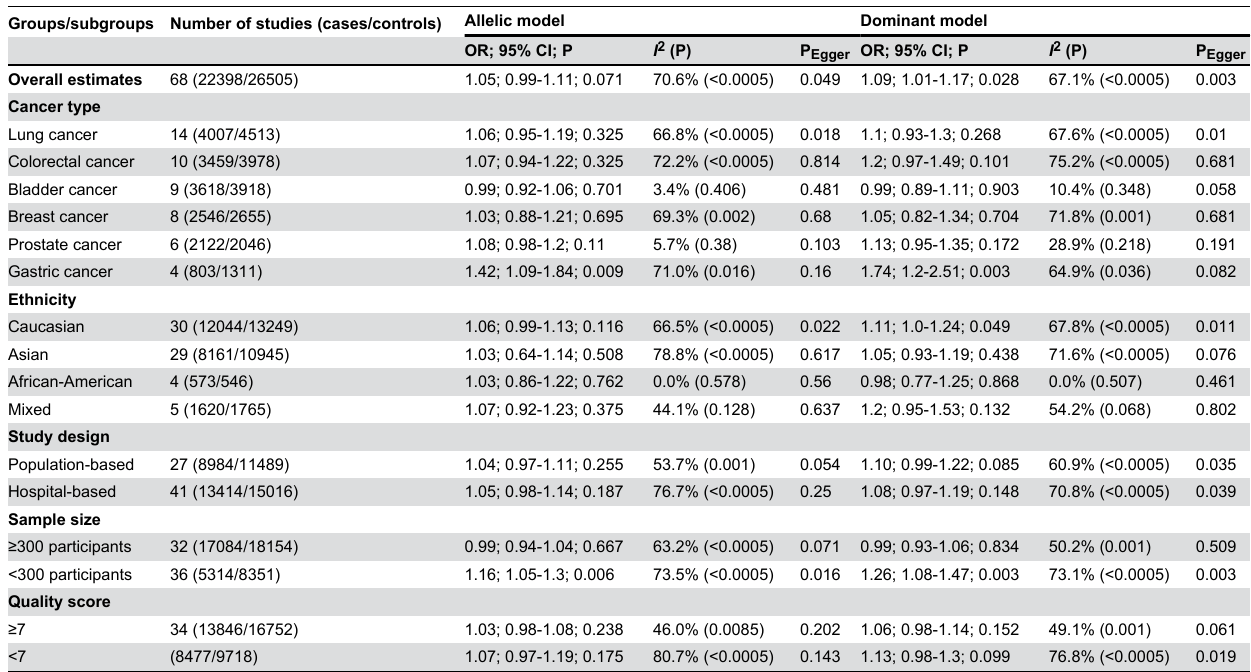
Table 2. Overall and subgroup estimates of the associations of APEX1 Asp148Glu polymorphism with cancer risk under allelic and dominant